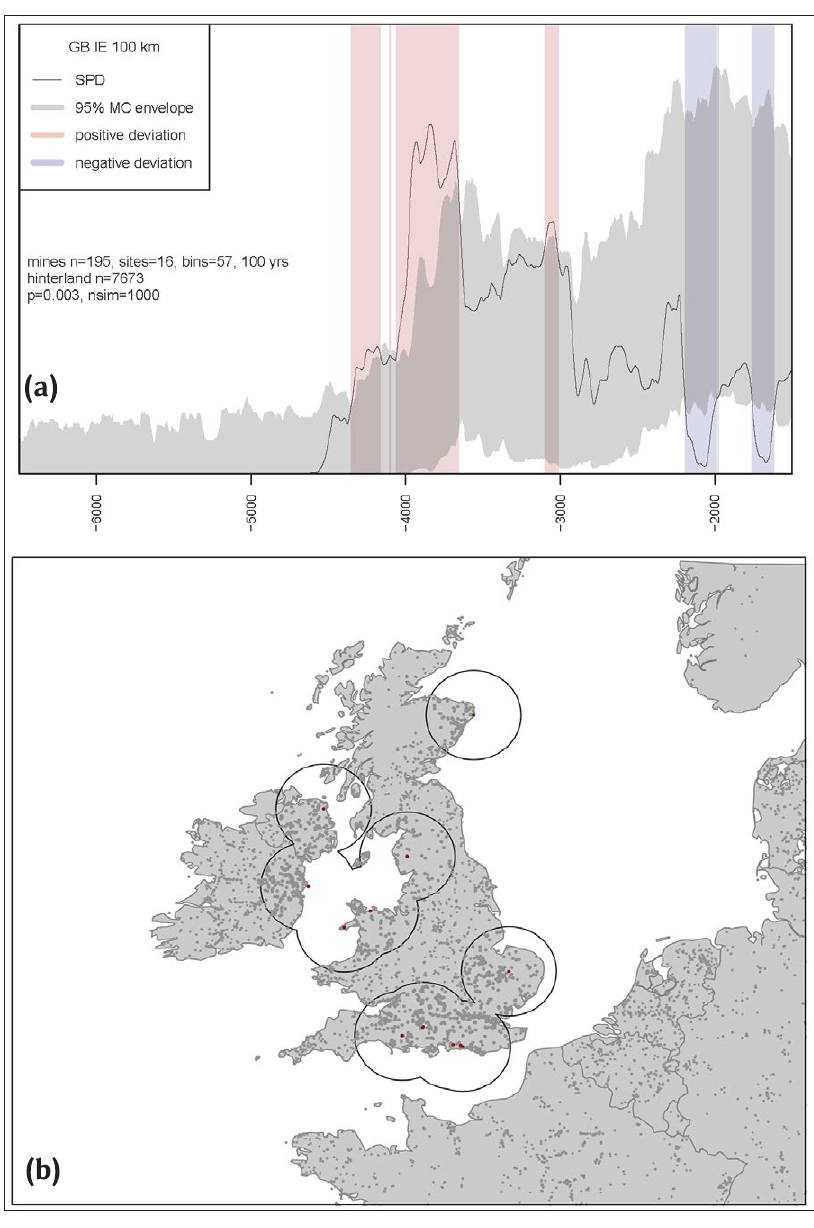
Figure 1: (a) The solid line shows the summed probability distribution (SPD) of the dates from all mines and quarries in Britain and Ireland, with dates grouped into 100 year bins. The grey area shows the 95% confidence interval derived from generating 1000 samples of dates from sites in the 100km radius hinterlands of all the mines/quarries combined. Periods where the mine SPD is higher than the hinterland SPD are shown in pink, periods were it is lower in blue. The overall significance of the departures = 0.003. The horizontal axis is in years BC. The vertical axis is a probability axis on which only relative values matter so no scale is given. (b) The map shows the locations of the mines and quarries in the analysis and their 100km radius hinterlands, including areas of overlap. Dates from sites in areas of overlap are only counted